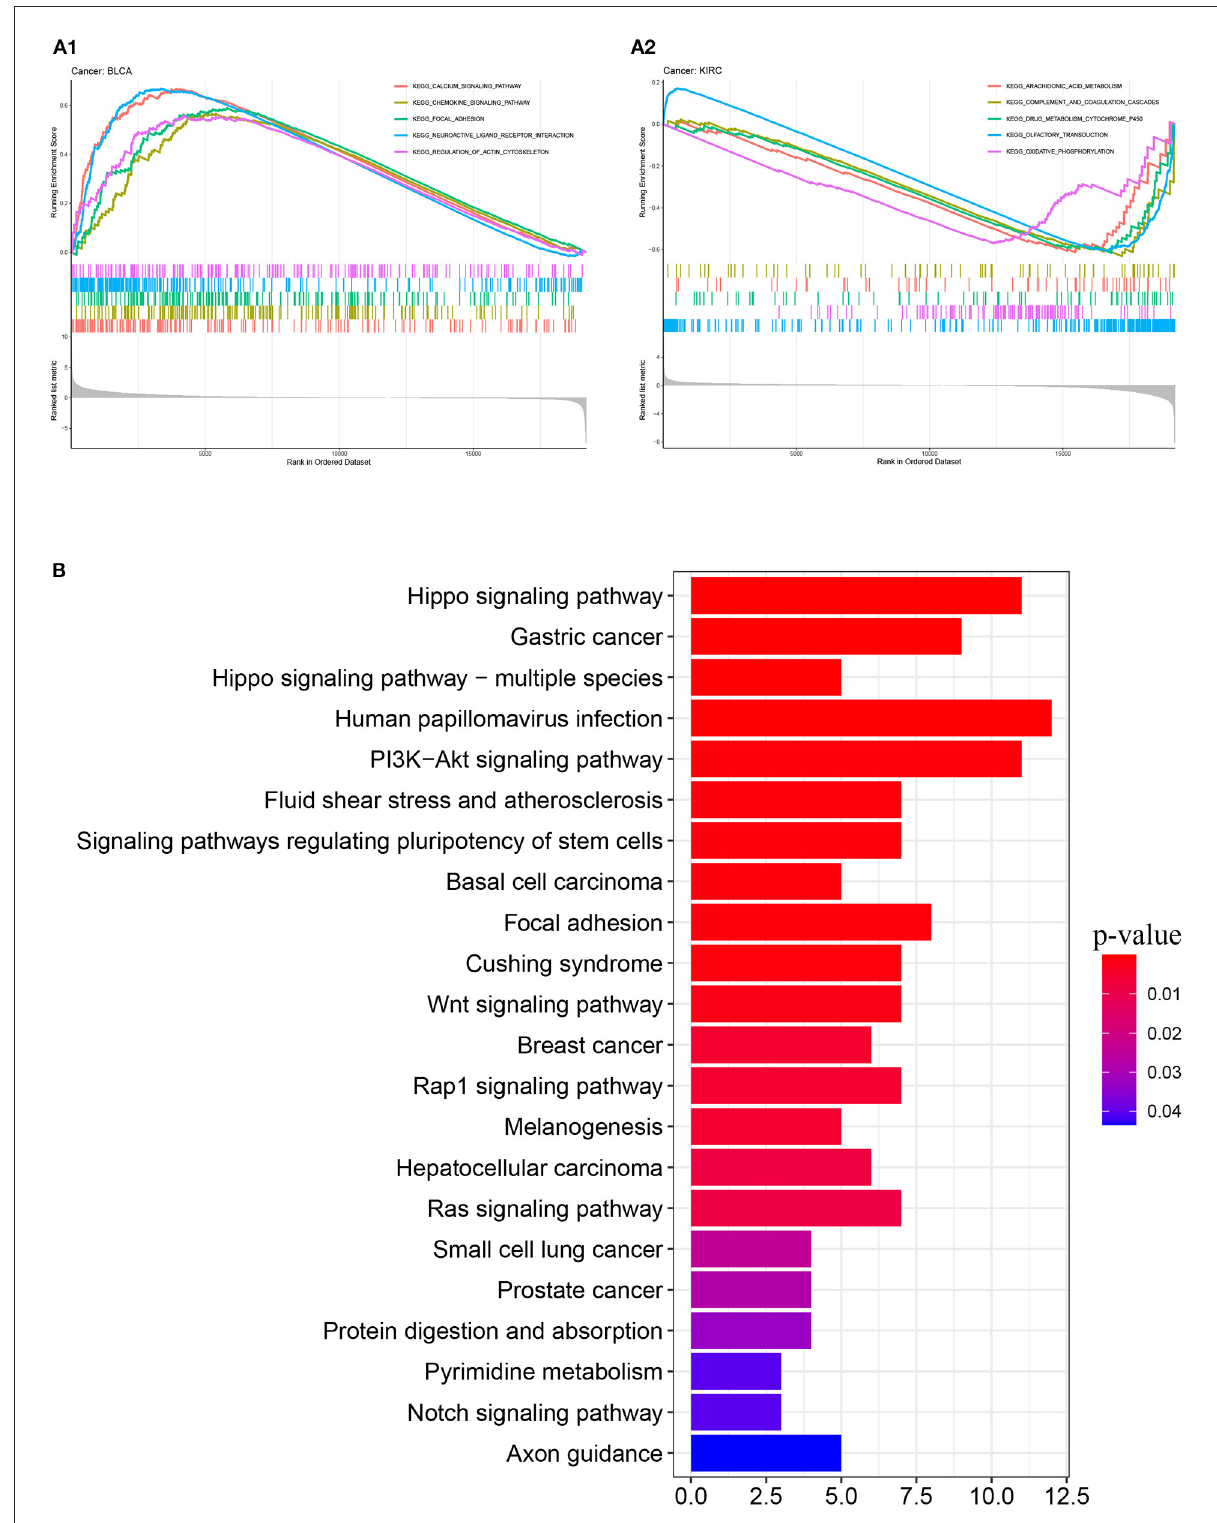
FIGURE8 GSEA enrichment analysis and KEGG pathway analysis. (A) GSEA enrichment analysis with BLCA and KIRC. (B) KEGG pathway analysis. The y-axis shows top 20 significantly enriched pathway, and the x-axis displays the enrichment scores of these terms ( P -value < 0.05).